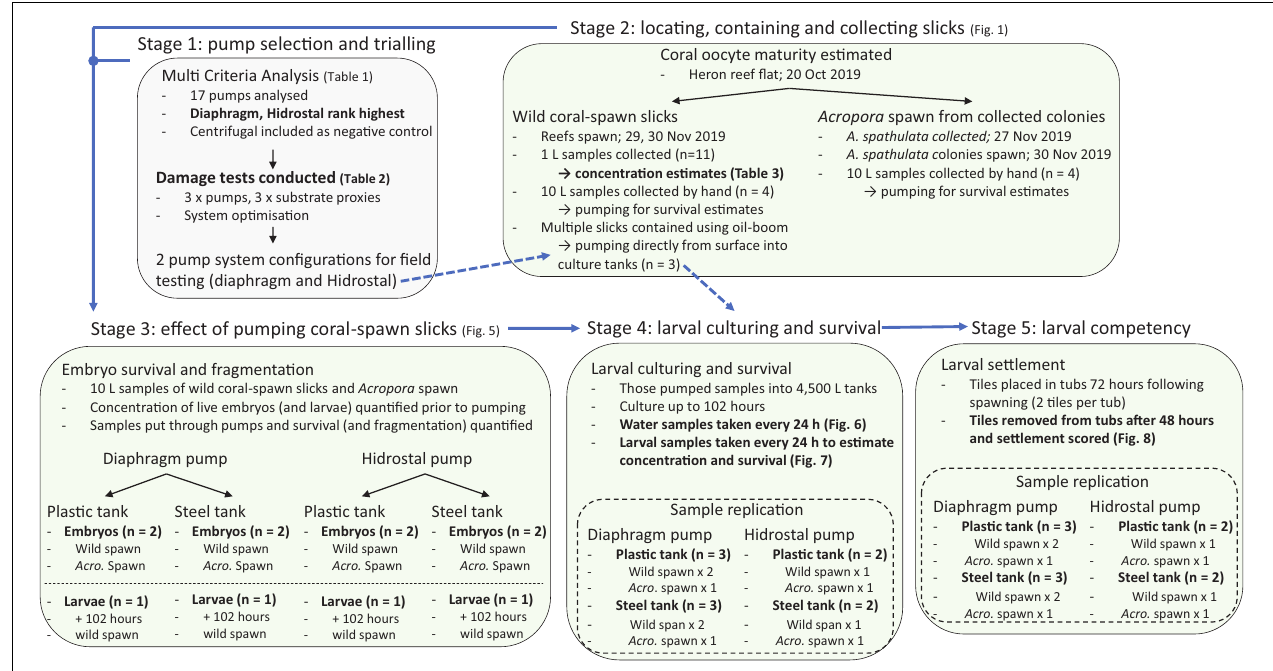
FIGURE 2 | Workflow diagram presenting the overall approach of the study, the five major stages, time-points of observations, and replication for each experiment.